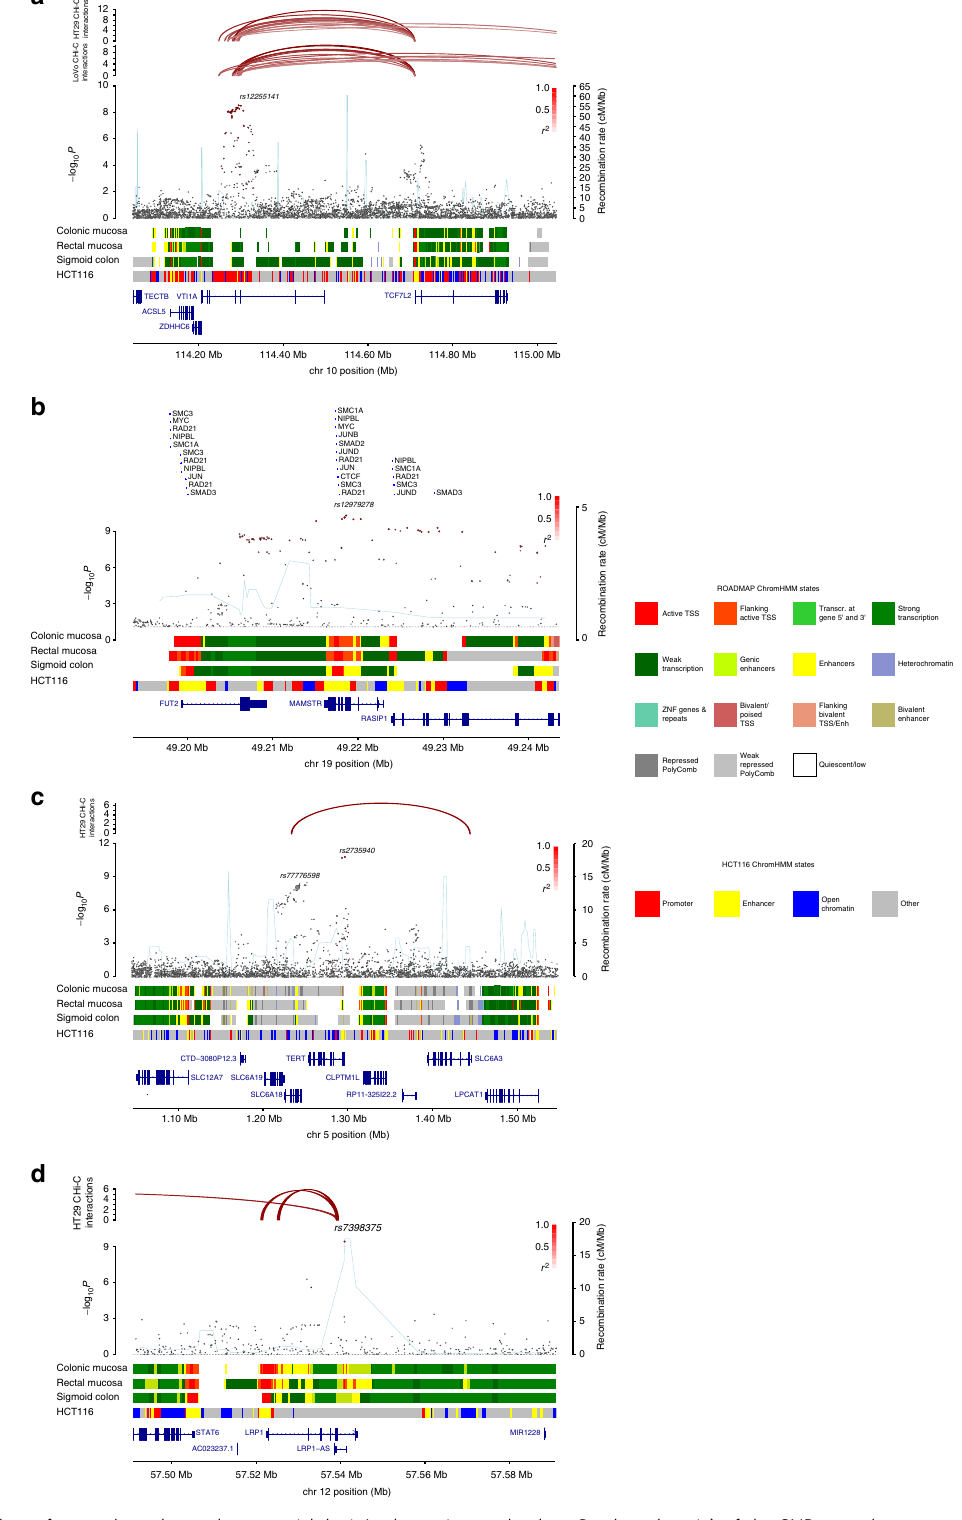
Fig. 3 Regional plots of exemplar colorectal cancer risk loci. In the main panel, − log 10 P -values (y-axis) of the SNPs are shown according to their chromosomal positions (x-axis). The colour intensity of each symbol re fl ects the extent of LD with the top SNP: white ( r 2 = 0) through to dark red ( r 2 = 1.0), with r 2 estimated from EUR 1000 Genomes data. Genetic recombination rates (cM/Mb) are shown with a light blue line. Physical positions are based on GRCh37 of the human genome. Where available, the upper panel shows Hi-C contacts from HT29 or LoVo. The lower panel shows the chromatin state segmentation track from the Roadmap Epigenomics project (colonic mucosa, rectal mucosa, sigmoid colon), and HCT116. Also shown are the relative positions of genes and transcripts mapping to each region of association. a rs12255141 (10q25.2); b rs12979278 (19q13); c rs2735940 (5p15); d rs7398375